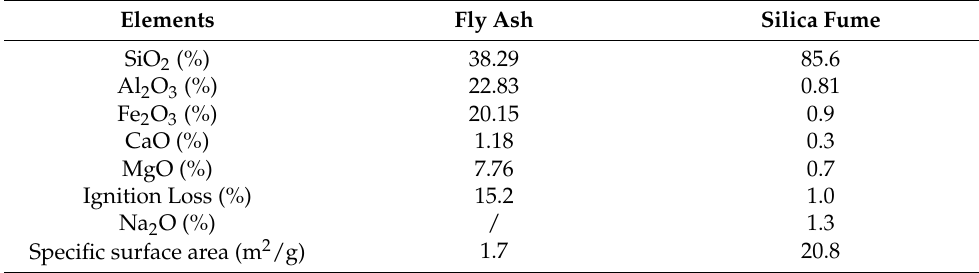
Table 5. Chemical compositions of fly ash and silica